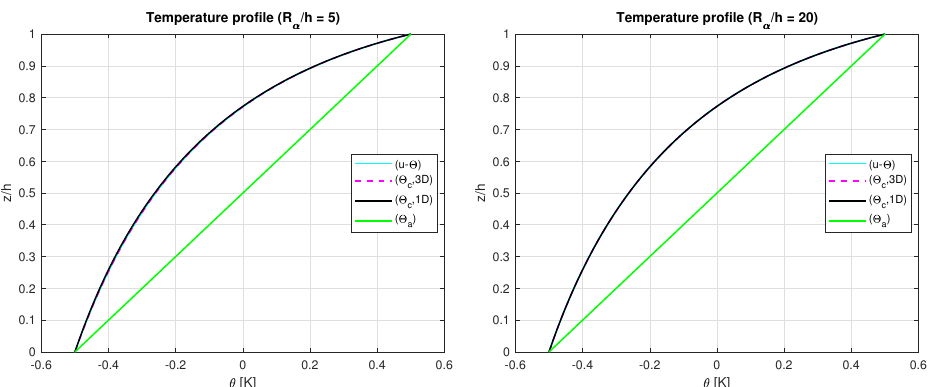
Figure 6. Second benchmark, temperature profiles for thick and moderately thick simply supported cylinders with one FGM ( p = 1) layer. The maximum amplitude of the temperature θ ( α , β , z ) is evaluated at the centre of the cylinder ( a /2, b /2). Table 4. Second benchmark, simply supported cylinder with one FGM ( p = 1) layer.